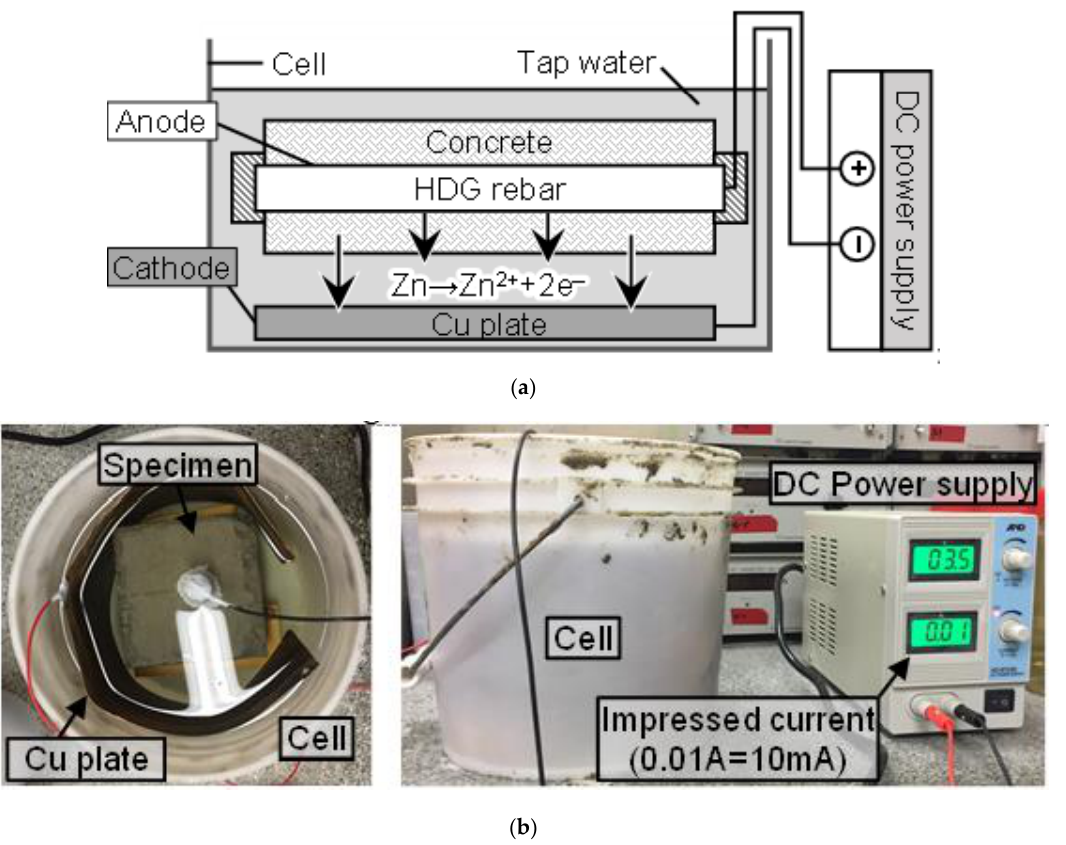
Figure 2. ( a ) Acceleration test; ( b ) View of the acceleration test as the current was impressed on the specimen. Table 3. Mix proportion of concrete for the specimen.